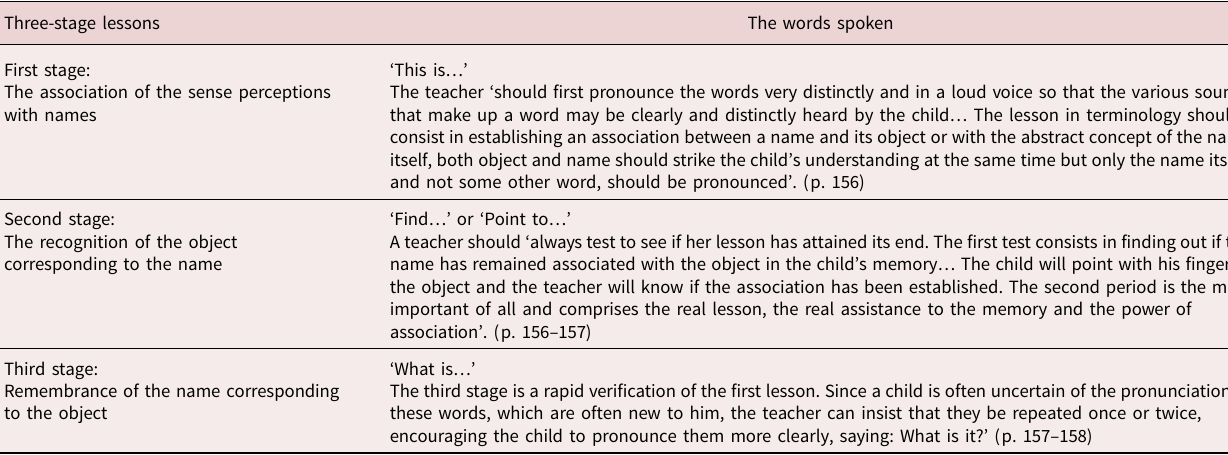
Table 1. Presentation of didactic materials: three-staged lessons (Montessori, 1967) Three-stage lessons The words spoken First stage: The association of the sense perceptions with